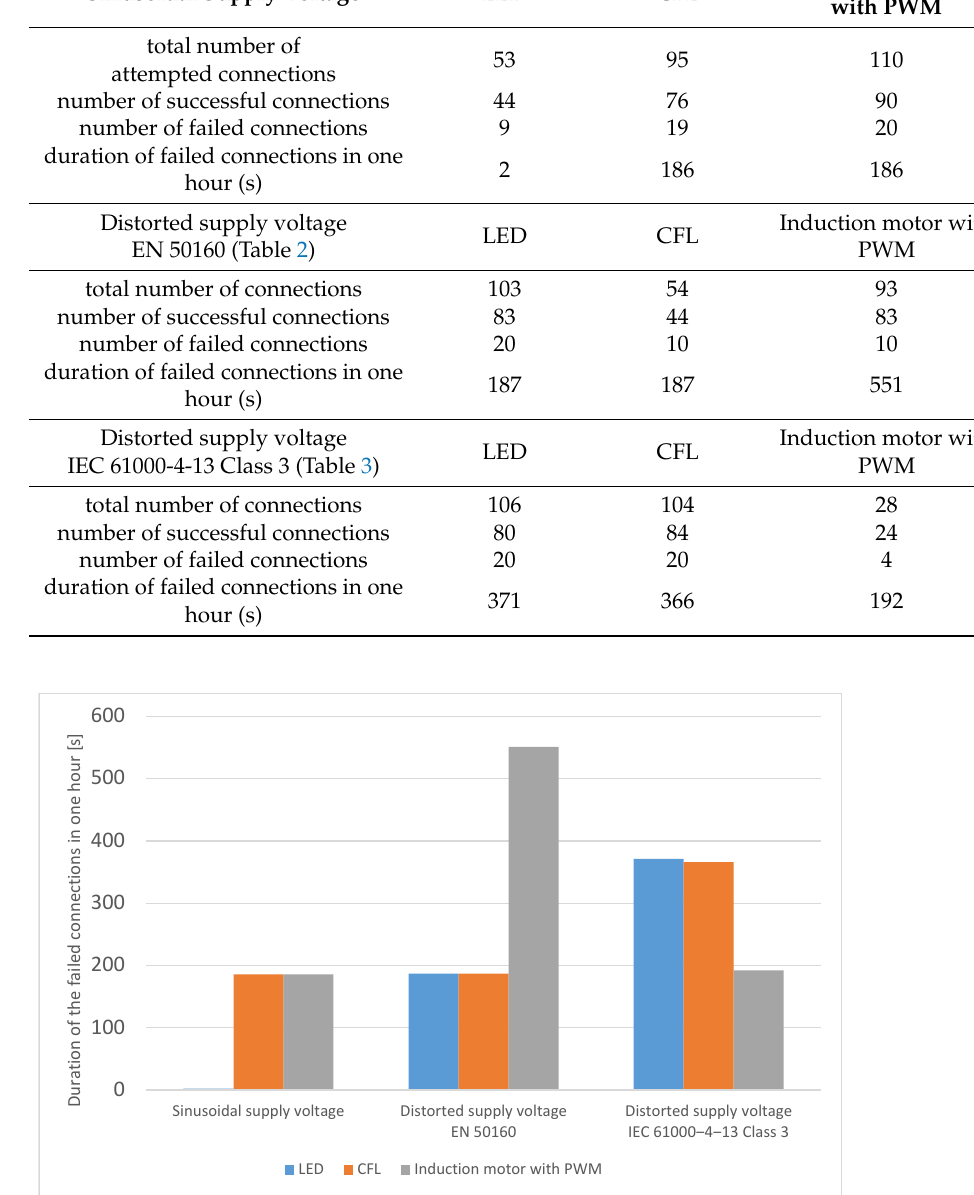
Figure 13. Impact of the supply voltage distortion grade on the duration of the failed connections in one hour of the investigated PRIME PLC system.